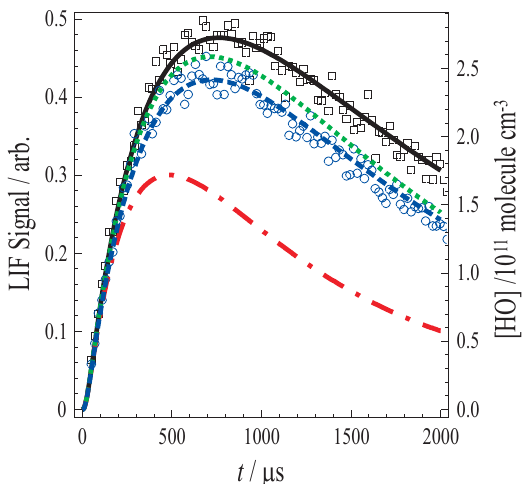
Fig. 3. OH LIF profiles recorded following HO 2 generation in the presence of NO (1.6 × 10 14 moleculecm − 3 ) at 228 K and 85 Torr. Black square datapoints were obtained with [CH 3 C(O)CH 3 ] = 0; the black solid line is the associated numerical simulation used to calibrate the LIF signal response. Blue circles depict data obtained at [CH 3 C(O)CH 3 ] = 1.0 × 10 15 moleculecm − 3 and are associated with three numerical simulations. Results from simulations using theoretical values of k 1 and k − 1 from Hermans et al. are depicted as the red dot-dashed line. The green dotted line represents k 1 = 0 (indistinguishable from simulations using parameters from, Cours et al., 2007). As indicated by the blue dashed line, the data could be reasonably well reproduced using much smaller values of K 1 (see Sect.